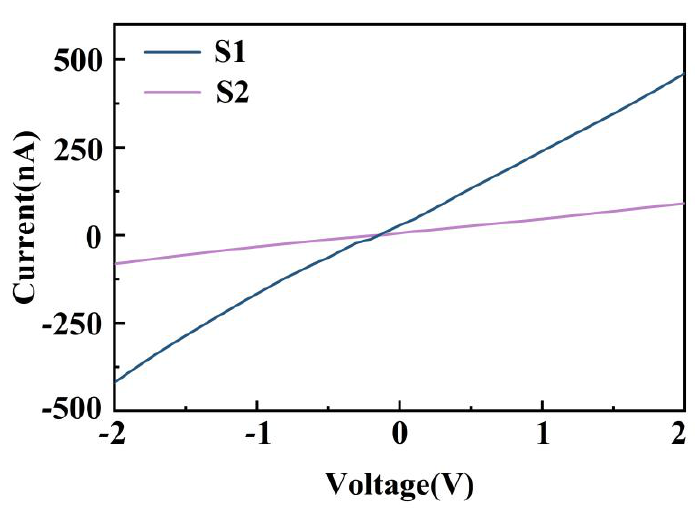
Figure 7. I–V curve of sensor based on MoS 2 at 1000 ppm CH 2 O.